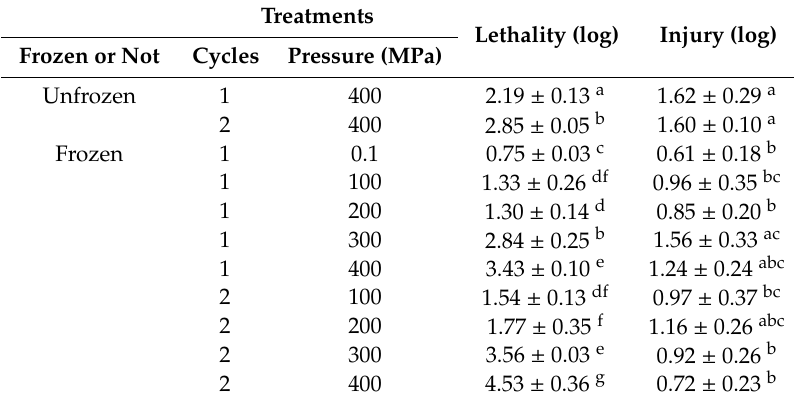
Table 1. The injury extent and lethality extent of the E. coli strains in inoculated milk resulting from di ff erent treatments. Mean values ± standard deviation ( n =